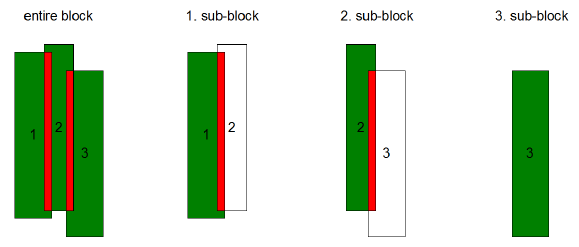
Figure 4: Concept of sub-blocks using the example of three strips, green: 5-ray points, red: 10-ray points This strategy on the basis of three overlapping strips is depicted in Fig. 4. Three sub-blocks are built up in the combinations 1 & 2,